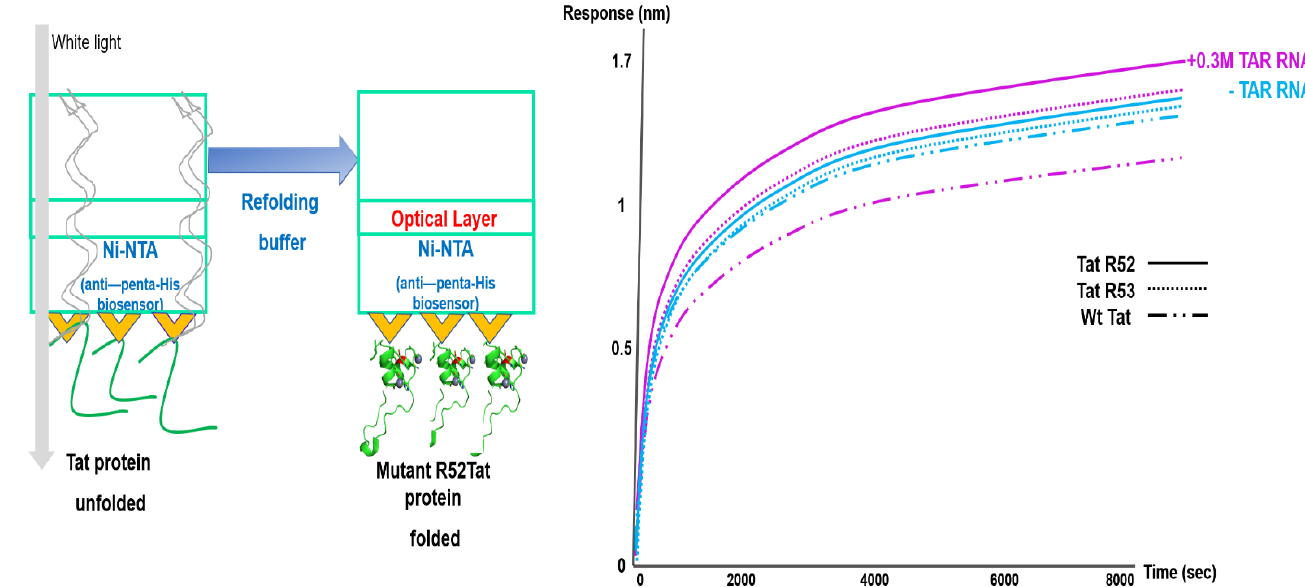
Figure 5. Comparative kinetic analysis of refolding using biolayer interferometry with mutant R52Tat in the presence of TAR RNA. The effects of mutant R52Tat on the refolding yield in the presence of 0.3 μ M TAR RNA within HeLa lysates. Immobilized His-tagged wild-type and mutant Tat refolding was assessed using an anti-penta-His biosensor on an Octect RED 96 system by monitoring the function of chaperna through a TAR RNA assay in HeLa lysates. A representative BLI color sensogram is shown, indicating a preferential increase in mutant Tat refolding in the presence of TAR RNA (red lines) relative to wild-type Tat refolding, which is related to the hydrophobic surfaces as chaperna progresses. The refolding of wild-type Tat (middle dotted line), TatR52 (solid line), and TatR53 (dotted line) in the absence of TAR RNA (blue lines) and the refolding of wild-type Tat (middle dotted line), TatR52 (solid line), and TatR53 (dot line) in the presence of 0.3 µ M TAR RNA (red lines) are shown (specific binding to anti-penta-His; left y -axis). All the data are the average of duplicate experiments. Color plots represent the data range. Buffer baselines were subtracted from all the data.